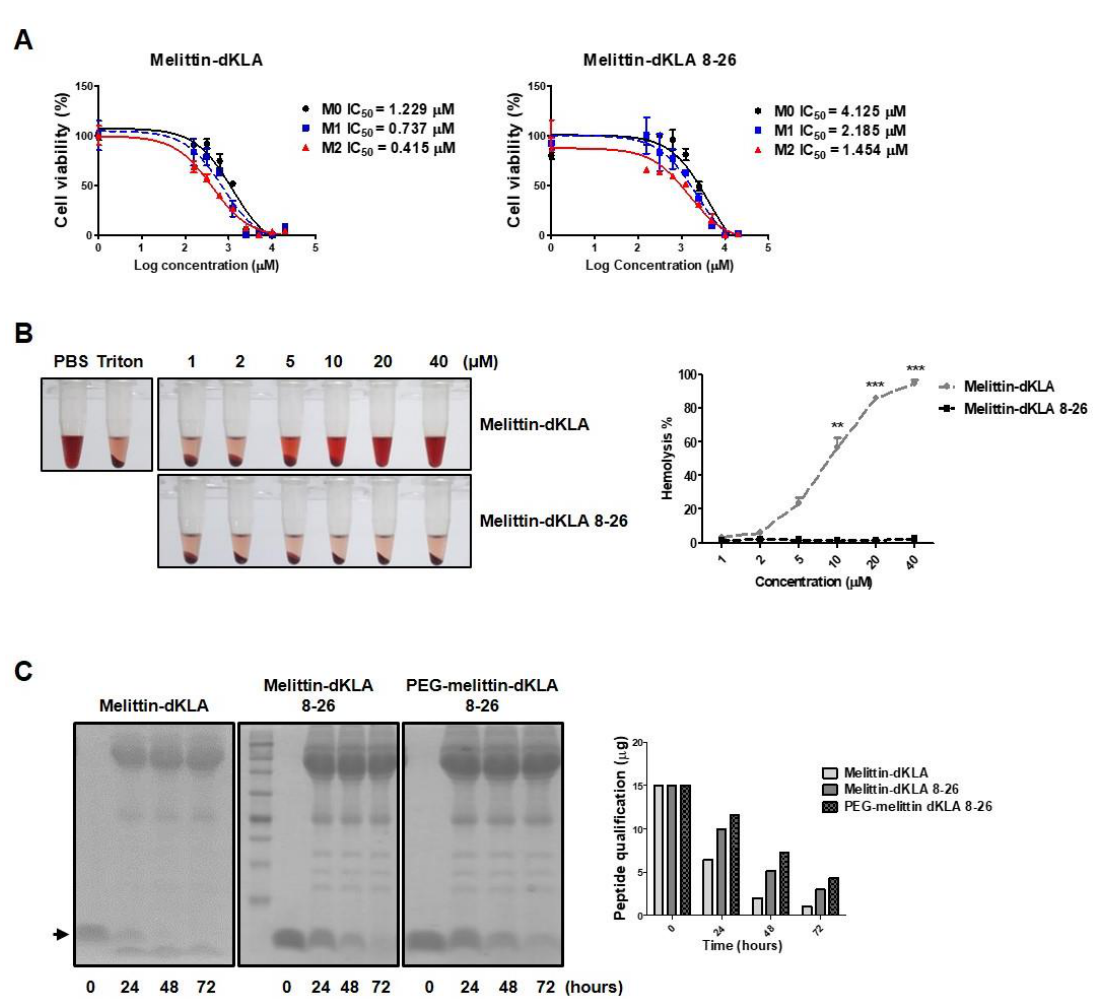
Figure 4. Characterization of the optimized hybrid peptide drug, PEG-melittin-dKLA 8-26. ( A ) MTS assay of melittin-dKLA or melittin-dKLA 8-26 in macrophages. Human THP-1 was stimulated with 100 nM PMA for 24 h and polarized into M1 macrophages using 100 ng/mL LPS and 20 ng/mL IFN- γ and into M2 macrophages using 20 ng/mL IL-4 and 20 ng/mL IL-13. Cells were treated with melittin or melittin-dKLA 8-26 at concentrations ranging from 0 to 20 µ M for 20 h. After incubation, the media were removed, and cells were treated with MTS (3-(4,5-dimethylthiazol-2-yl)-5-(3-carboxymethoxyphenyl)-2-(4-sulfophenyl)-2H-tetrazolium) solution diluted in serum-free RPMI medium for 1 h. The optical density was measured at 490 nm. All experiments were performed in duplicates. ( B ) Hemolysis of melittin-dKLA or melittin-dKLA 8-26. Melittin-dKLA or melittin-dKLA 8-26 was added to red blood cells at concentrations ranging from 1 µ M to 40 µ M and incubated at 37 ◦ C for 4 h. 2% Triton-X 100-treated cells were used as the positive control, and PBS-treated cells were used as the negative control. The optical density of hemoglobin released in the supernatant was measured at 450 nm. The data are presented as the mean ± SEM; ** p < 0.01, *** p < 0.001 versus melittin-dKLA (n = 3). ( C ) Melittin-dKLA, melittin-dKLA 8-26, or PEG-melittin-dKLA 8-26 stability was examined via a stability test. Human serum was added to 15 µ g of peptides and incubated at 37 ◦ C for 0 h, 24 h, 48 h, and 72 h. Protein bands were visualized and measured by Image